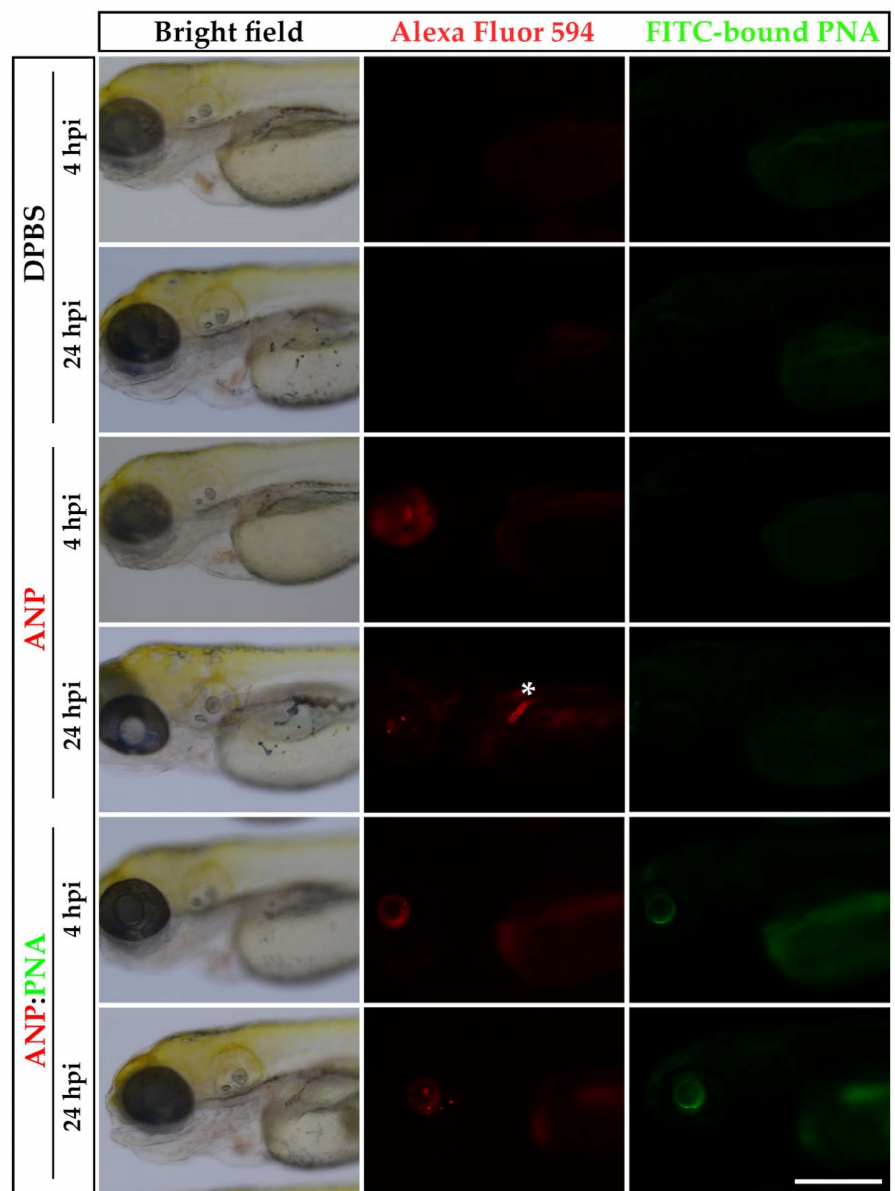
Figure 3. Prolonged localisation of nanoparticles at the site of injection. Representative images of 3 days post-fertilisation (dpf) larvae IVT injected with naked Alexa Fluor 594-positive nanoparticles (ANPs) or FITC-labelled PNA-conjugated polyacrylamide nanoparticles (ANP:PNA), analysed at 4 and 24 h post-injection (hpi). As control, zebrafish larvae were IVT injected with DPBS. White asterisk indicates the pronephros. n = 45 injected eyes from 3 independent experiments. Scale bar: 300 µ